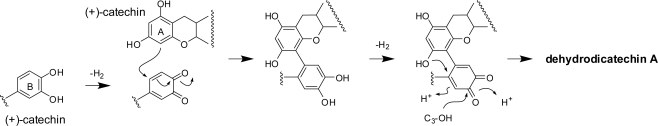
Production of dehydrotheasinensin A from (+)-catechin.